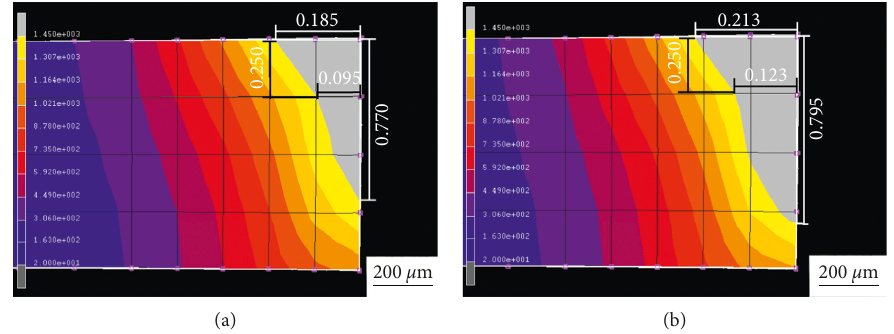
Figure 9: Numerical simulation results of temperature distribution and weld profile: (a) 250W, 2m/min, and 0 mm; (b) 250W, 1.2m/min, and 0mm.